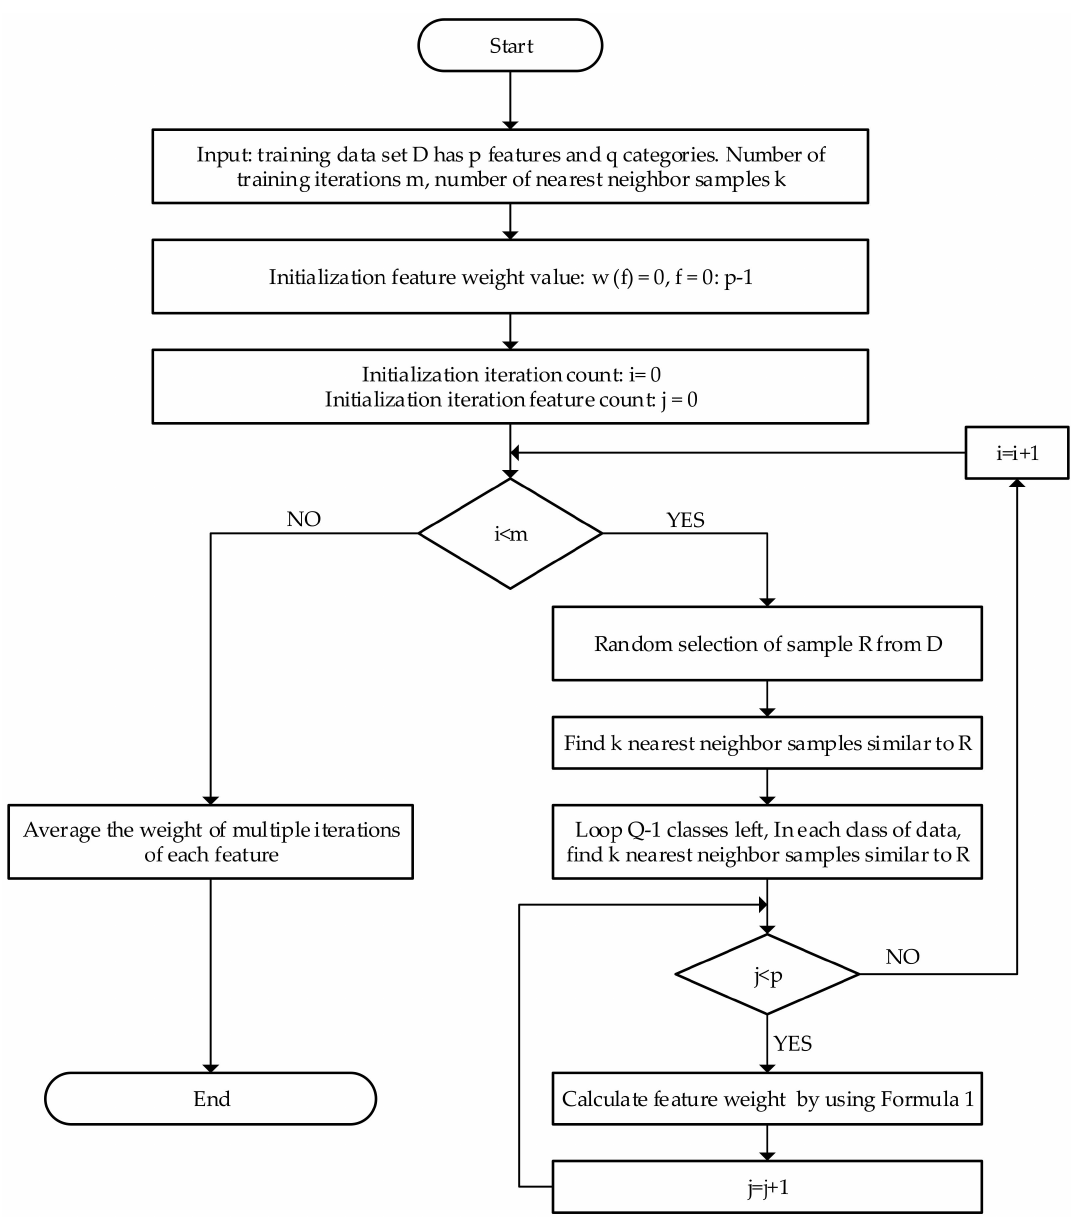
Figure 1. The flow chart of the ReliefF